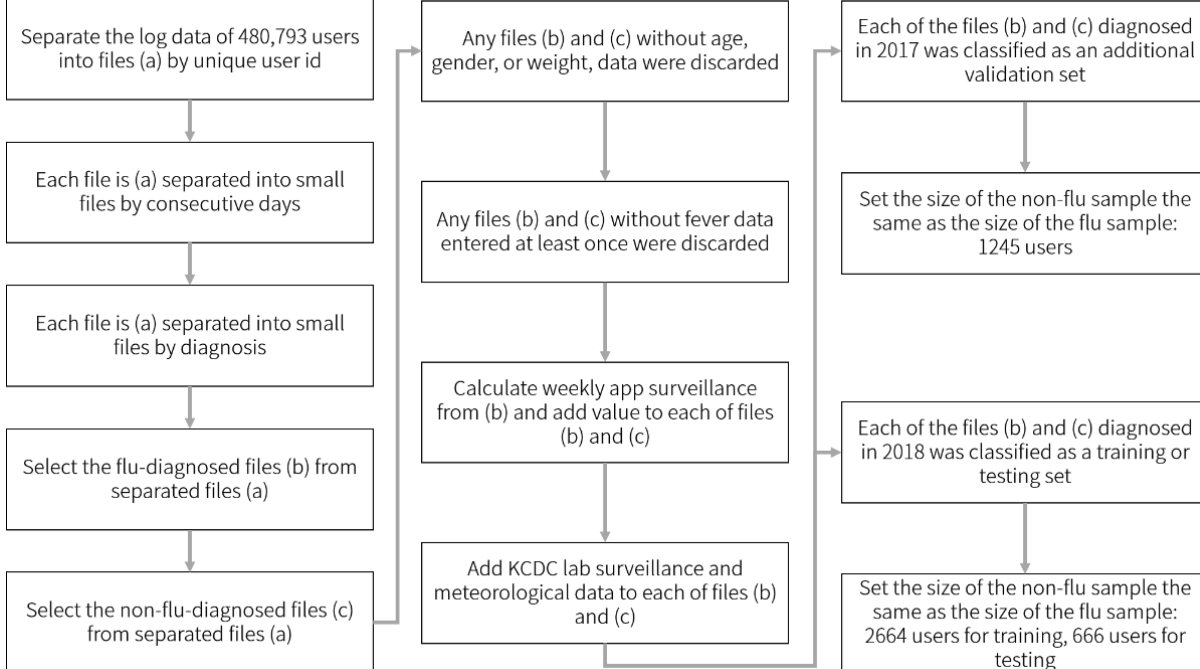
Figure 2. Pipeline for data preprocessing. KCDC: Korea Center for Disease